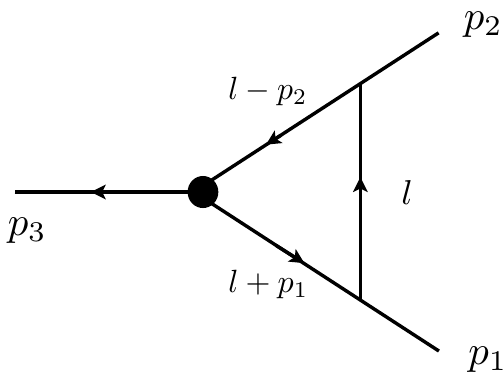
Figure 11 . One-loop correction to b B (3) in b φ 3 theory in d = 6 − (cid:15)